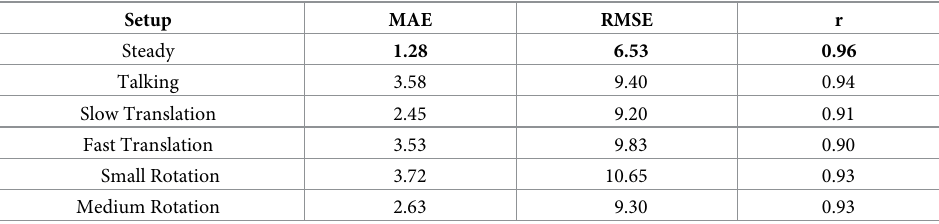
Table 4. Performance for different noise level of LA-SSA HR estimation. Setup